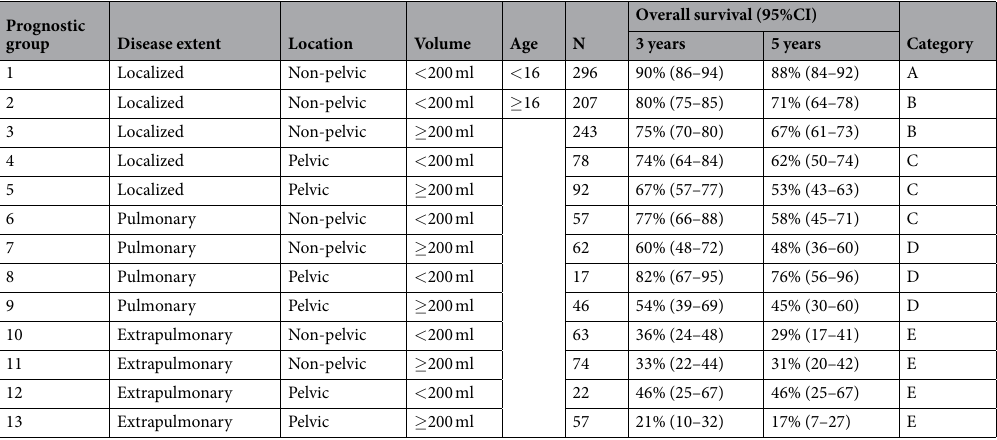
Table 3. Overall survival at 3 and 5 years for each prognostic group. Creation of 13 prognostic groups based on disease extent, tumor localization, volume and age showing overall survival (OS) with corresponding 95% confidence interval (CI) at 3 and 5 years. Last column shows the risk category based on clinical expertise (n = 1314).